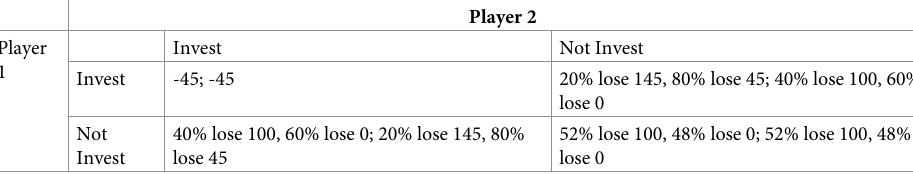
Table 2. Possible outcomes in the stochastic prisoner’s dilemma game.